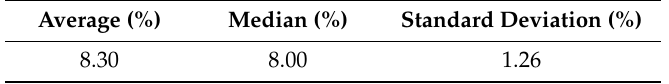
Table 2. Average, median, and standard deviation of the case study’s